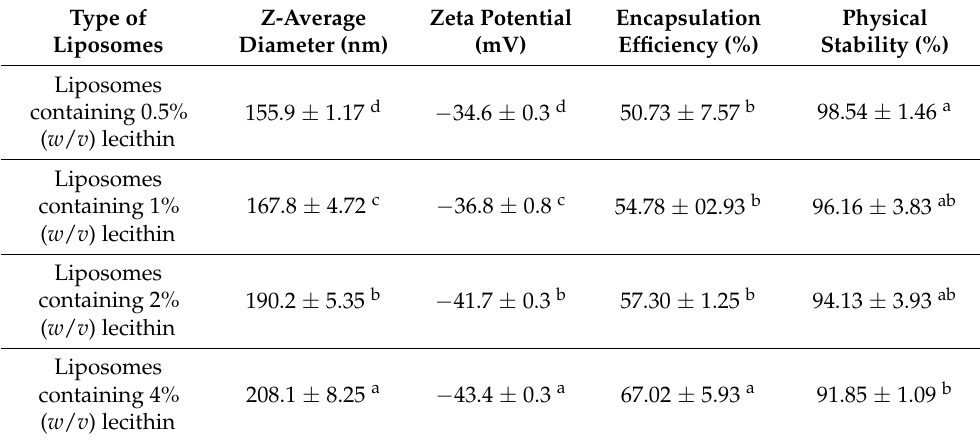
Table 1. Mean Z-average particle diameter, zeta potential, encapsulation efficiency, and stability of liposomes containing the saffron